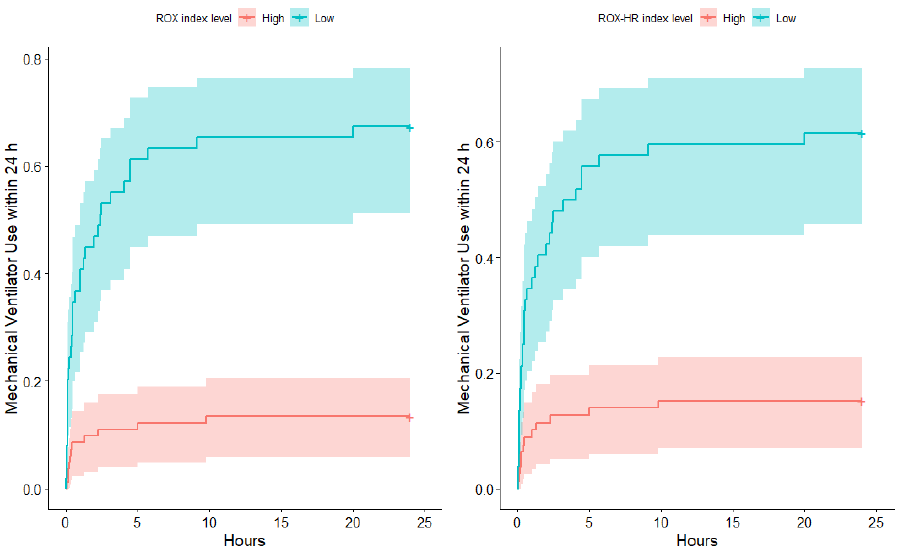
Figure 5. Kaplan – Meier curve for mechanical ventilator use within 24 h by ROX index ( left ) and ROX-HR index ( right ) level.